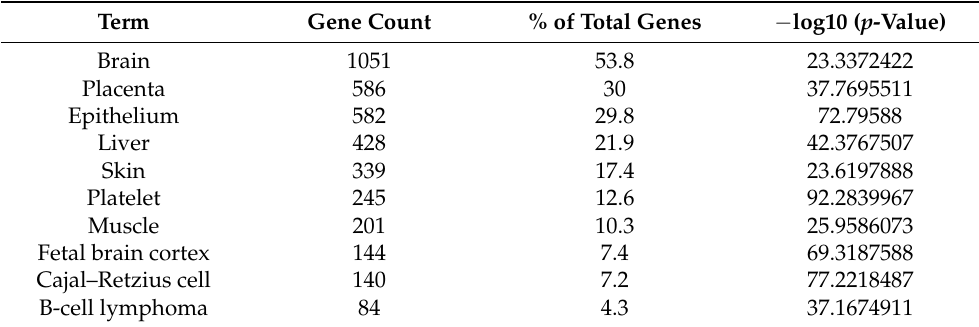
Table 1. Up-tissue analysis for proteins enriched in WT, DNAJB6-WT, and DNAJB6-M3 EVs: top 10 tissues are listed.